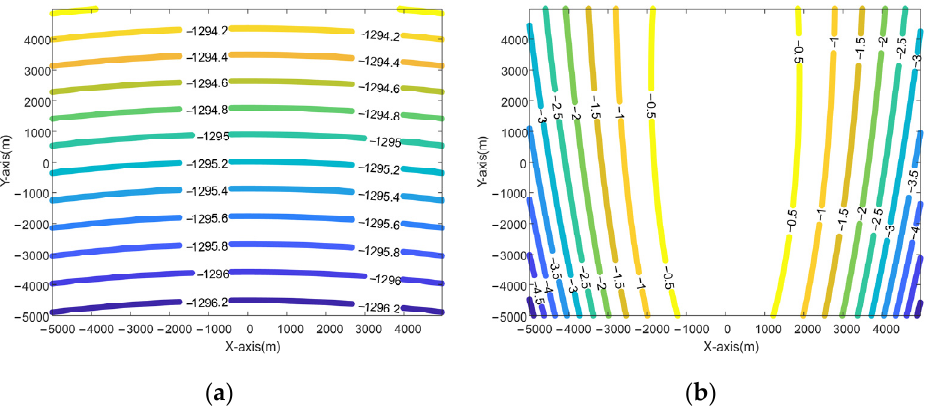
Figure 9. The distribution of K at and K ar . ( a ) Contour formed by K at of each point in the scene; and ( b ) Contour formed by K ar of each point in the